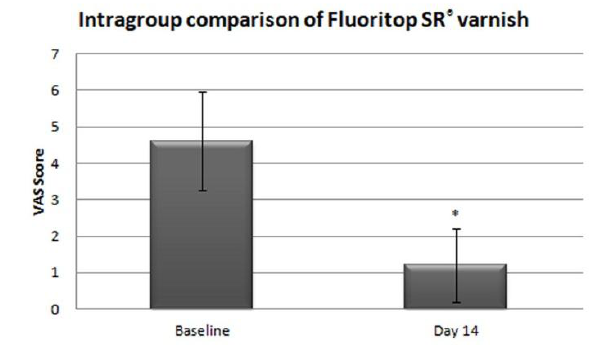
Figure 1 : Intragroup comparison at baseline and at 14th day (MI varnish®). VAS Score is expressed as mean±SD. *p < 0.05.